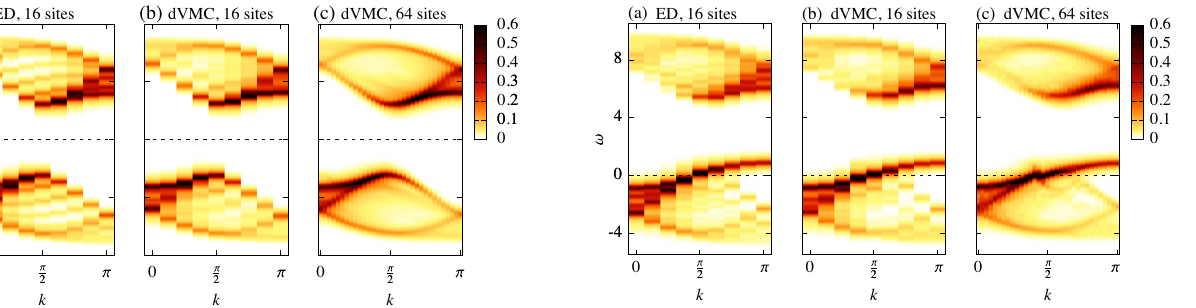
FIG. 3. Comparison of spectral weight for the doped 1D FIG. 2. Comparison of spectral weight for the 1D Hubbard 14 ) (b) with 16 ) calculated by the ED Hubbard model at U=t ¼ 8 ( L ¼ 16 and N model at half-filling ( L ¼ 16 and N e ¼ e ¼ the ED result (a). (c) Results of lightly doped 64-site chain (a) and by the present method dVMC (b). For the 16-site dVMC 56 ). Here, ω ¼ 0 is the Fermi level. The ( N ¼ 64 and N calculation, we considered combinations of every possible e ¼ choices of δ and δ 0 for panels (b) and (c) are the same as in Fig. 2. neighbor for the choice of δ and δ 0 in Eq. (18). Since the size 377 excitations are considered, in total, by is small, N exc ¼ omitting redundant excitations. In panel (c), we show the result 8 , resulting in for dVMC with 64 sites. We consider up to δ max ¼ 426 excitations. a total of N exc ¼